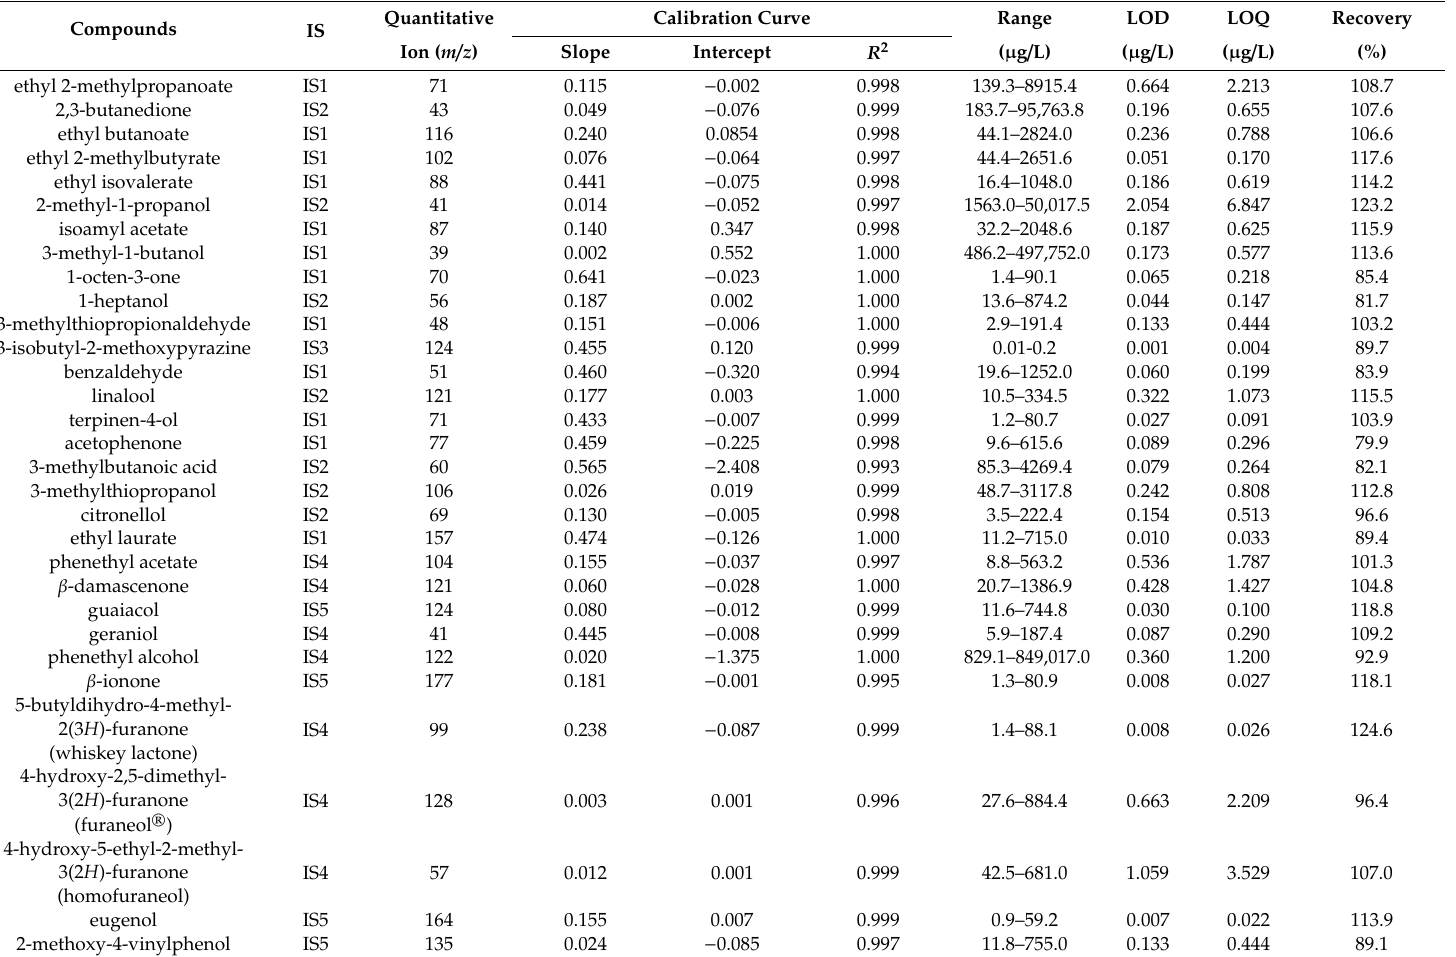
Table 4. Validation data for the chemical standards, quantitative ions, and calibrated intervals using GC ×